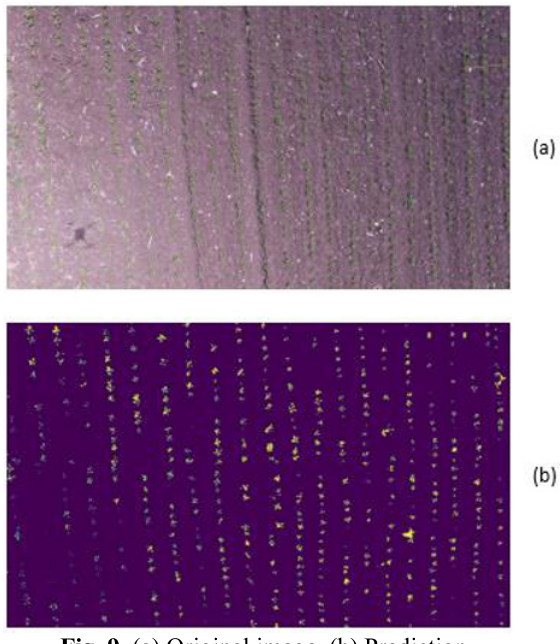
Fig. 9. (a) Original image, (b) Prediction Table 3. The SA and MIoU values for the tested methods.